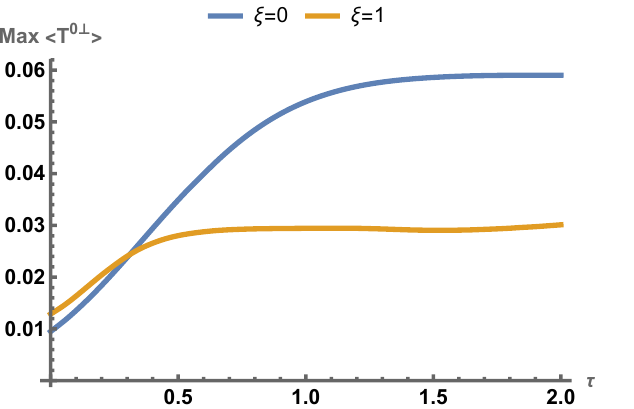
Figure 1 . The averaged, lab-frame transverse momentum density h T 0 ⊥ i = h (ˆ x ⊥ ) i T 0 i i up to first order in transverse derivatives, as a function of the transverse plane radius x ⊥ = proper time τ = 1 . 25 (left) and τ = 2 (right). Both plots display the averaged transverse energy flux at rapidity ξ = 0 (blue curve) and at ξ = 1 (yellow curve). The red dashed curves represent the exact results of [3]. At τ = 1 . 25 and low rapidities the first order approximation and the exact results agree very well. This agreement slightly deteriorates for larger rapidities and later proper times, but still remains quite good. We work in units in which the maximum of the longitudinally integrated energy density is set to 1.